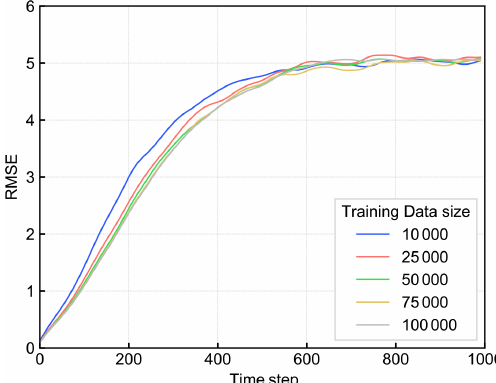
with various lengths of training data, with perfect observations and a perfect model. Each color corresponds to the value of the size of training